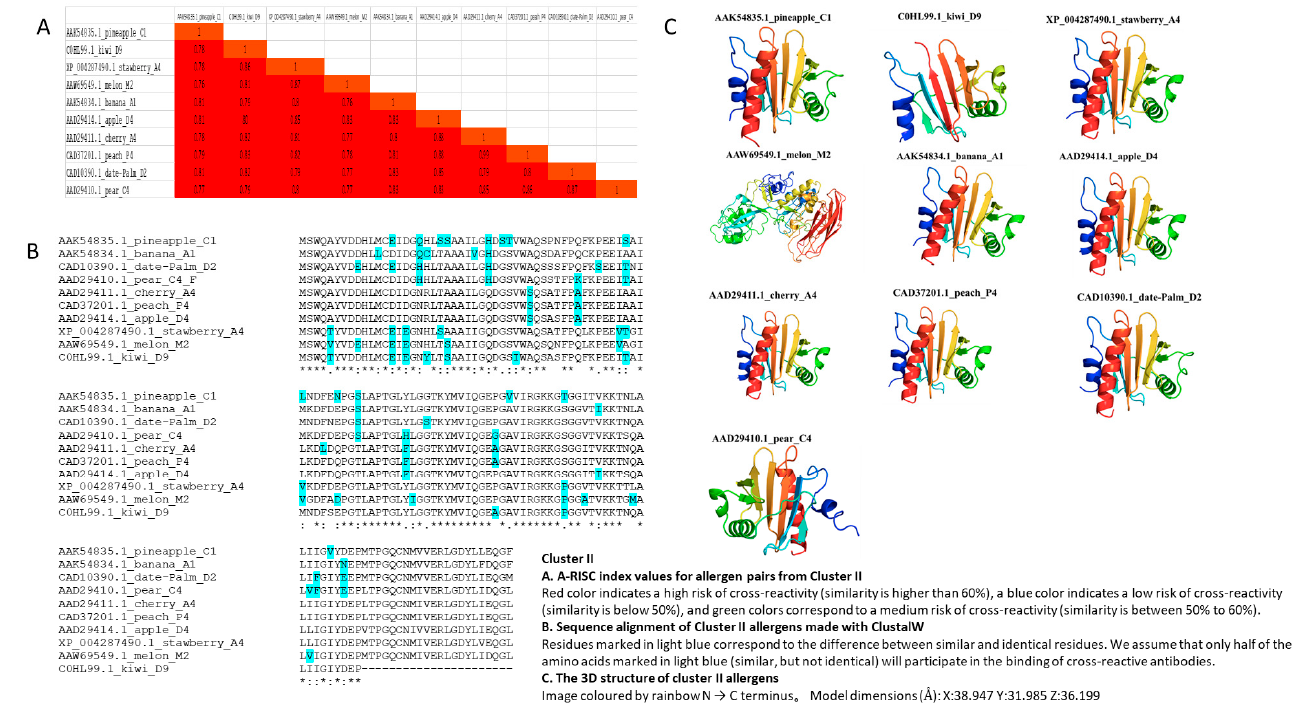
Figure 3. A-RISC index values, sequence alignment, and 3D structure of Cluster